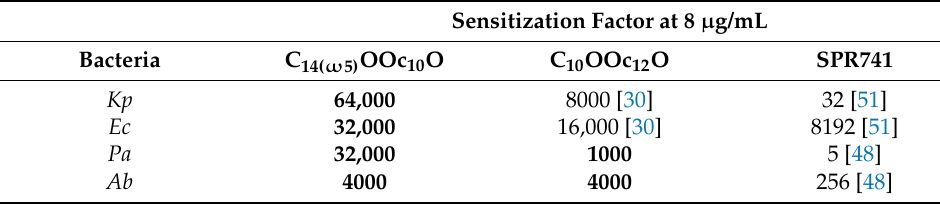
Table 2. Sensitization of Gram-negative bacteria to